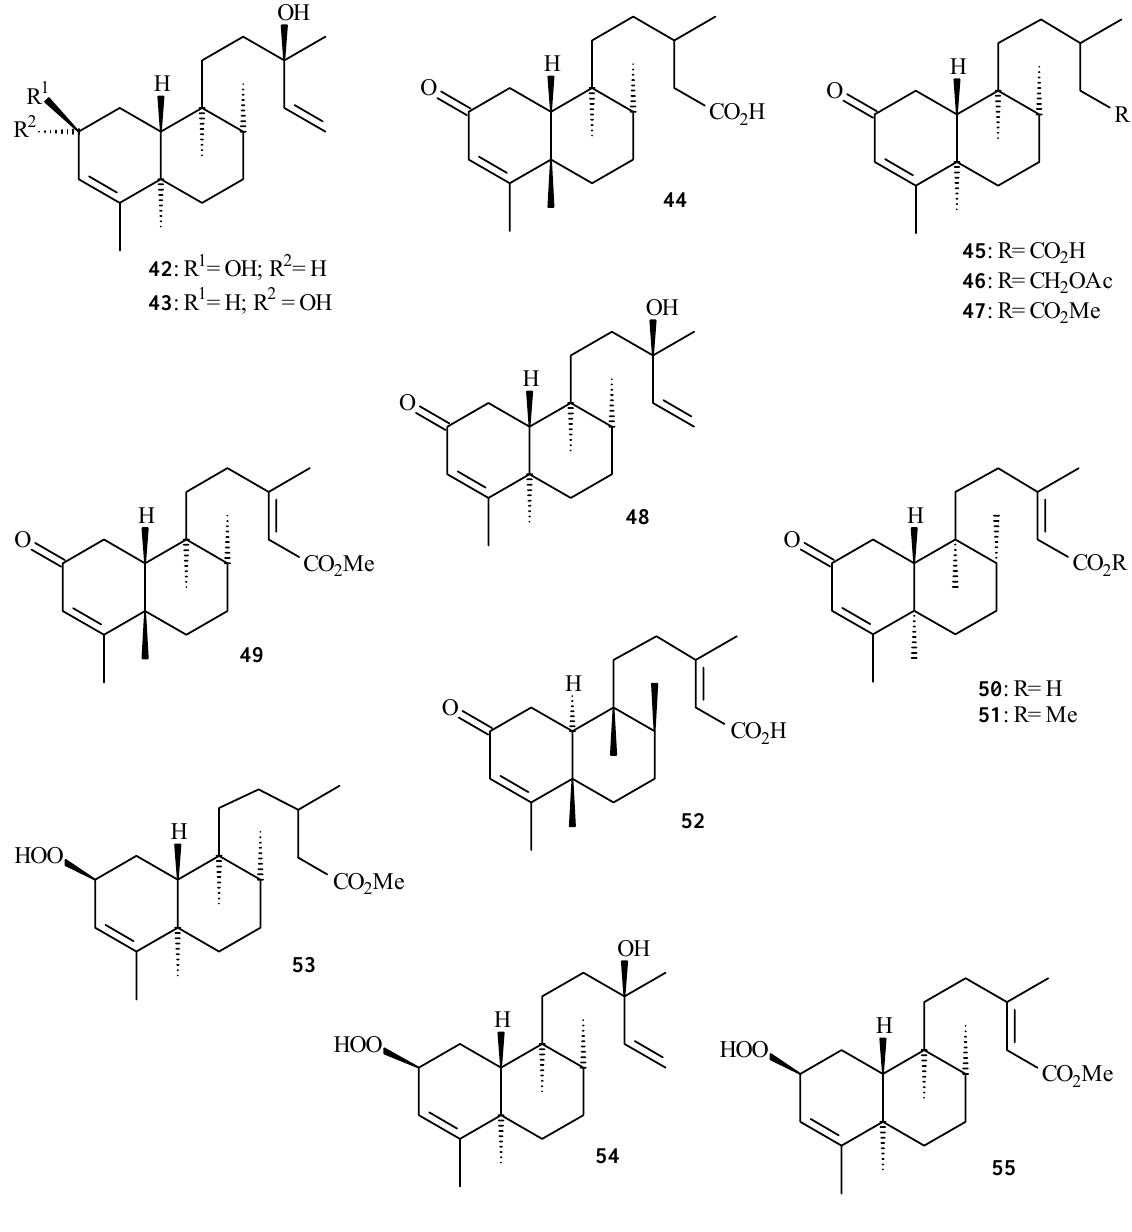
Figure 5. Clerodane diterpenoids isolated from Aristolochia species, showing oxygened